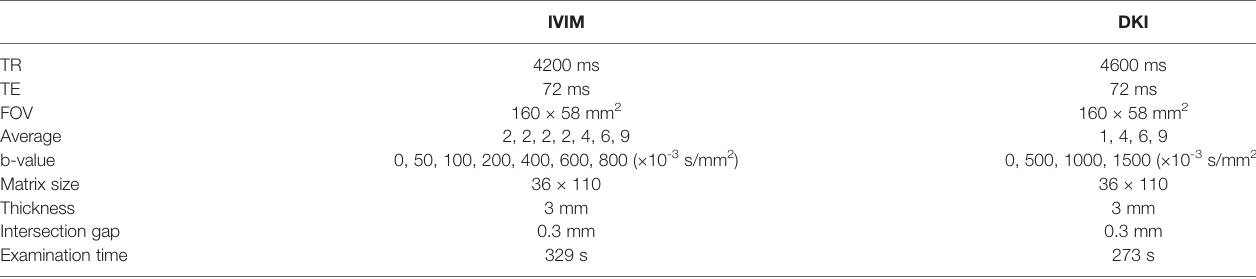
TABLE 1 | Imaging parameters of IVIM and